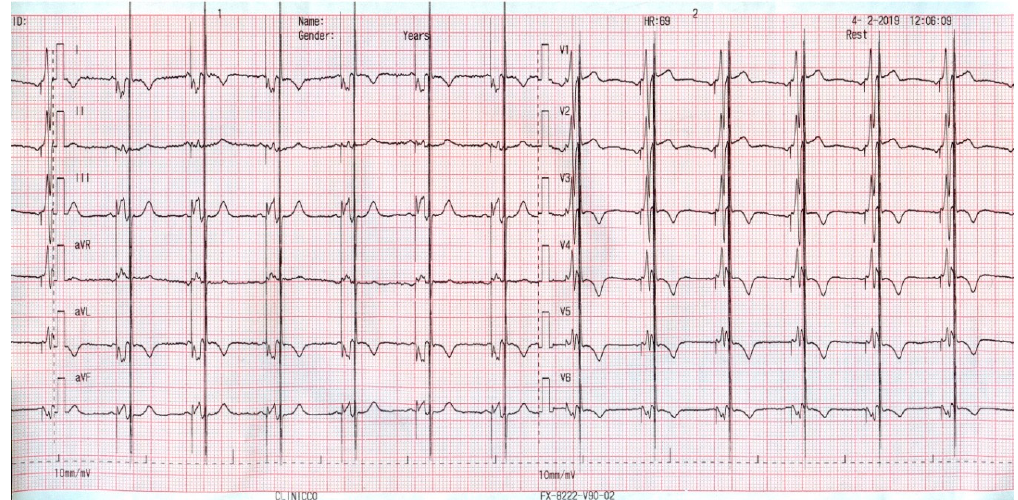
Figure 2. ECG aspect of a patient supported with a cardiac resynchronization therapy and defibrillator (CRT-D) and CCM.